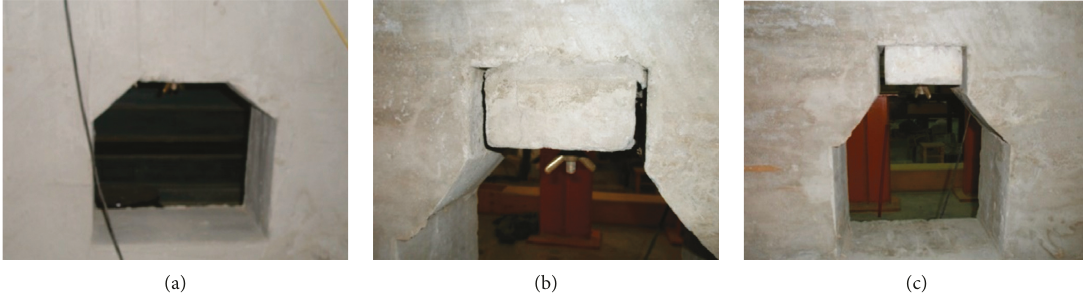
Figure 13: Models of surrounding rock with different damage degrees. (a) Intact model. (b) Damage model. (c) Failure model.